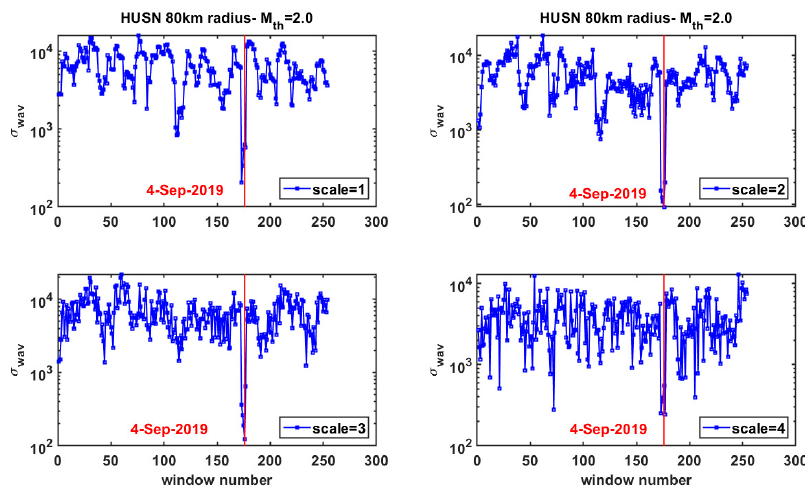
Figure 5. Time variation of σ wav ( m ) with scale m ranging from 1 up to 4, for moving windows with length of 16 events and a shift of 2 events. Interevent times were estimated using the HUSN catalogue (from January 2016 until 3 March 2021), for events within a radius R = 30 km ( top 4 plots ), 50 km ( middle 4 plots ) and 80 km ( bottom 4 plots ) around the M w = 6.3 epicenter and a magnitude threshold, M th = 2.0. Red vertical line indicates the day of minimum in variance, observed at each scale.